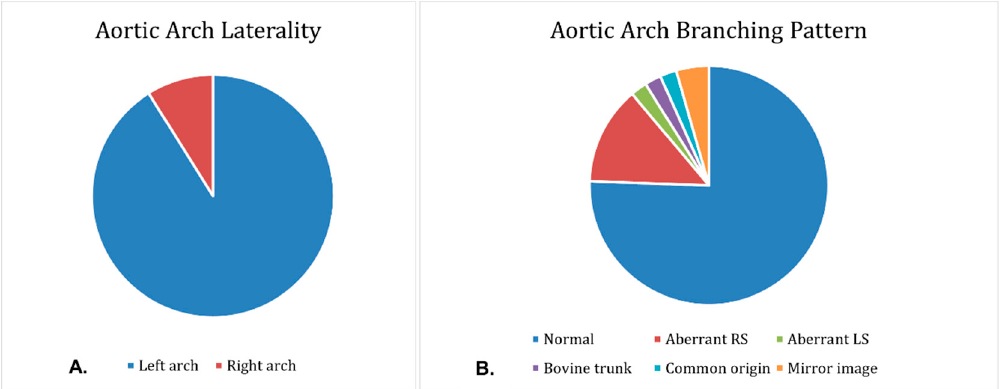
Figure 3. Pie charts showing ( A ) aortic arch laterality and ( B ) aortic arch branching patterns.